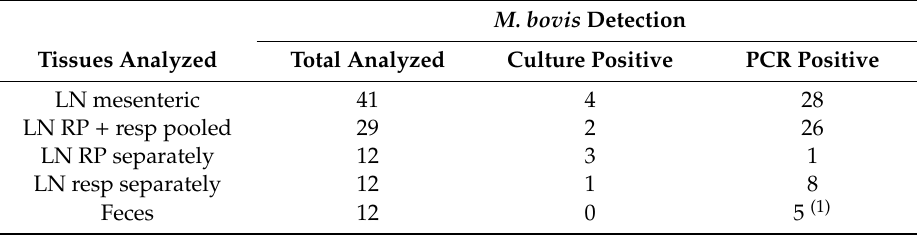
Table 4. Results of M. bovis detection in the di ff erent tissues of the infected foxes found